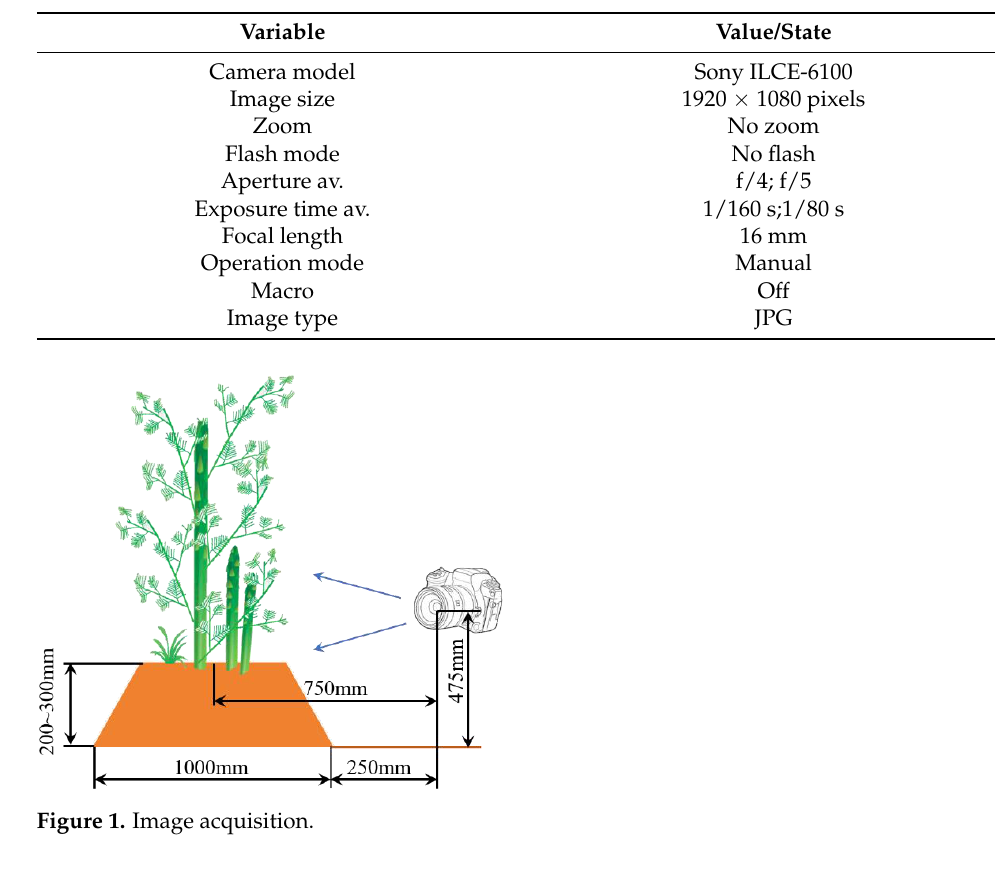
Table 1. Camera setting parameters.